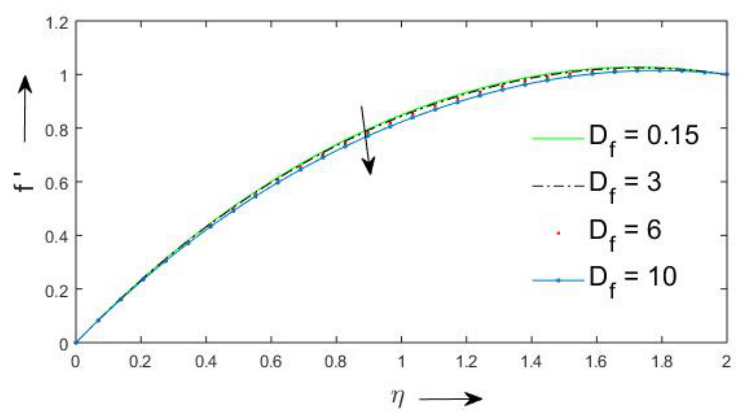
Figure 5: Distribution velocity due to D